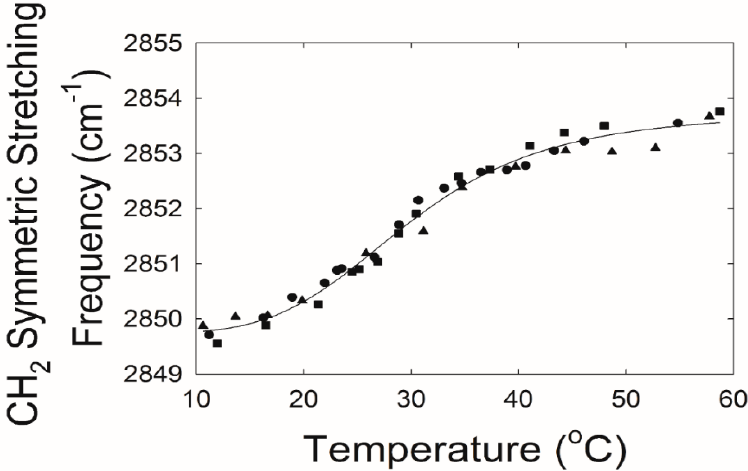
Figure 3. Lipid phase transitions of tear lipids from a 63-year-old Caucasian male with no dry eye. The CH 2 symmetric stretching frequency is related to the lipid structural order. The higher the value for the frequency, the more disordered the lipid. Symbols are different trials. Solid line is the fit of the data to a sigmoidal equation (see Section 4).